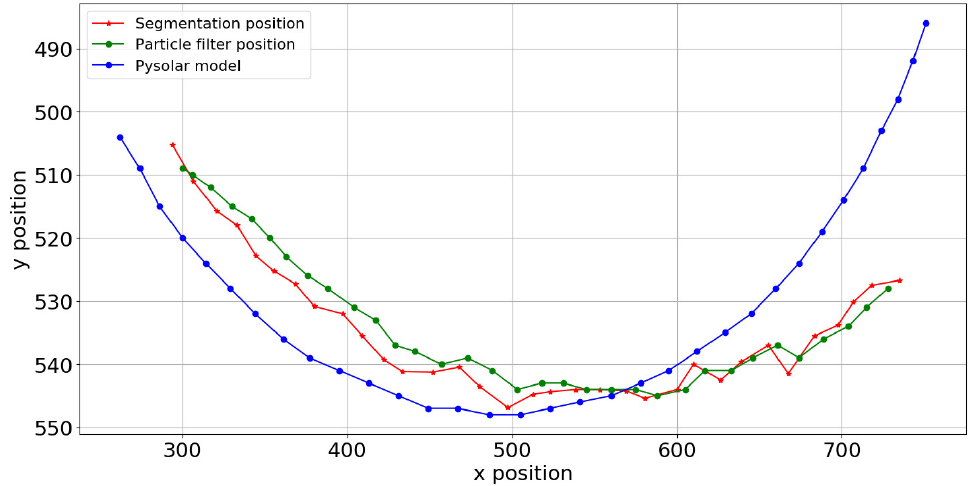
Figure 23. Trajectory of the Sun during a day where we can always detect